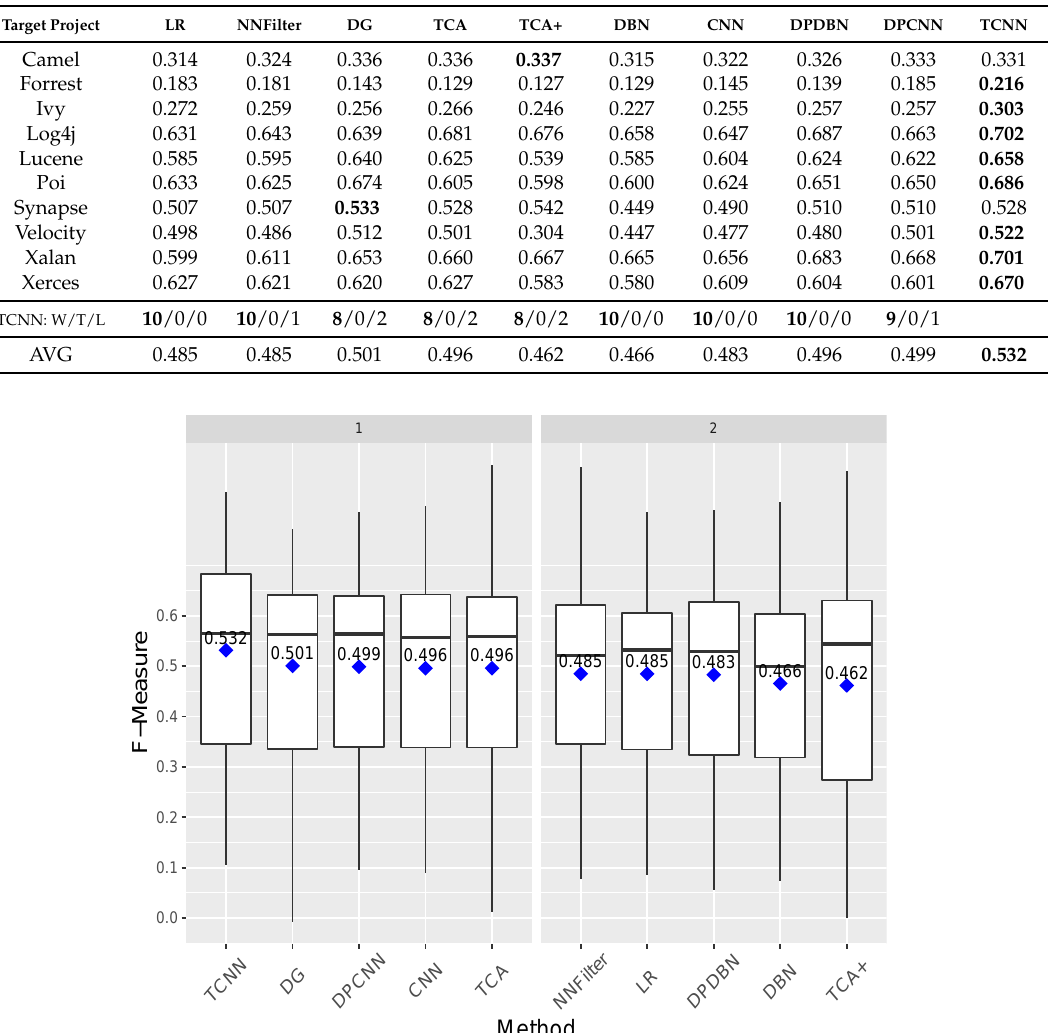
Figure 4. The Scott–Knott effect size difference (ESD) ranking of 10 different methods across the 90 pairs of cross-project defect prediction (CPDP) tasks. The blue diamond indicates the average F-measure of our studied